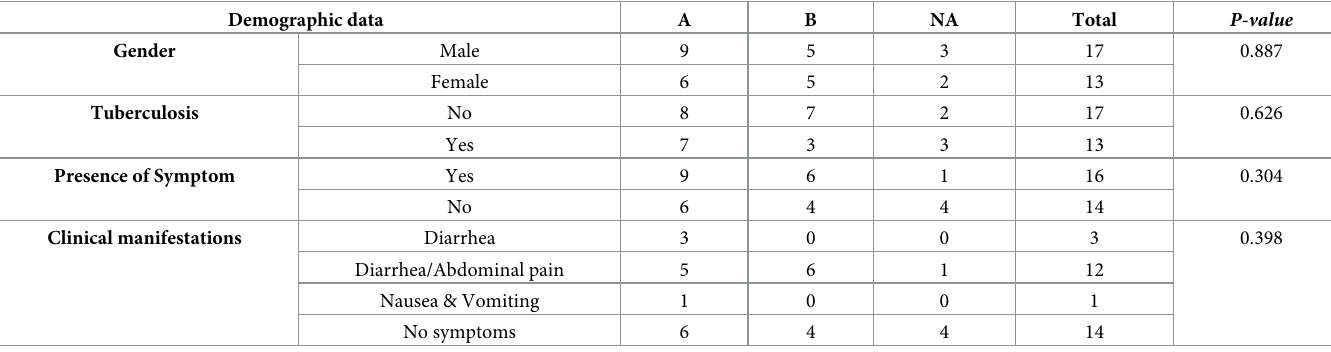
Table 2. The correlation between demographic data and